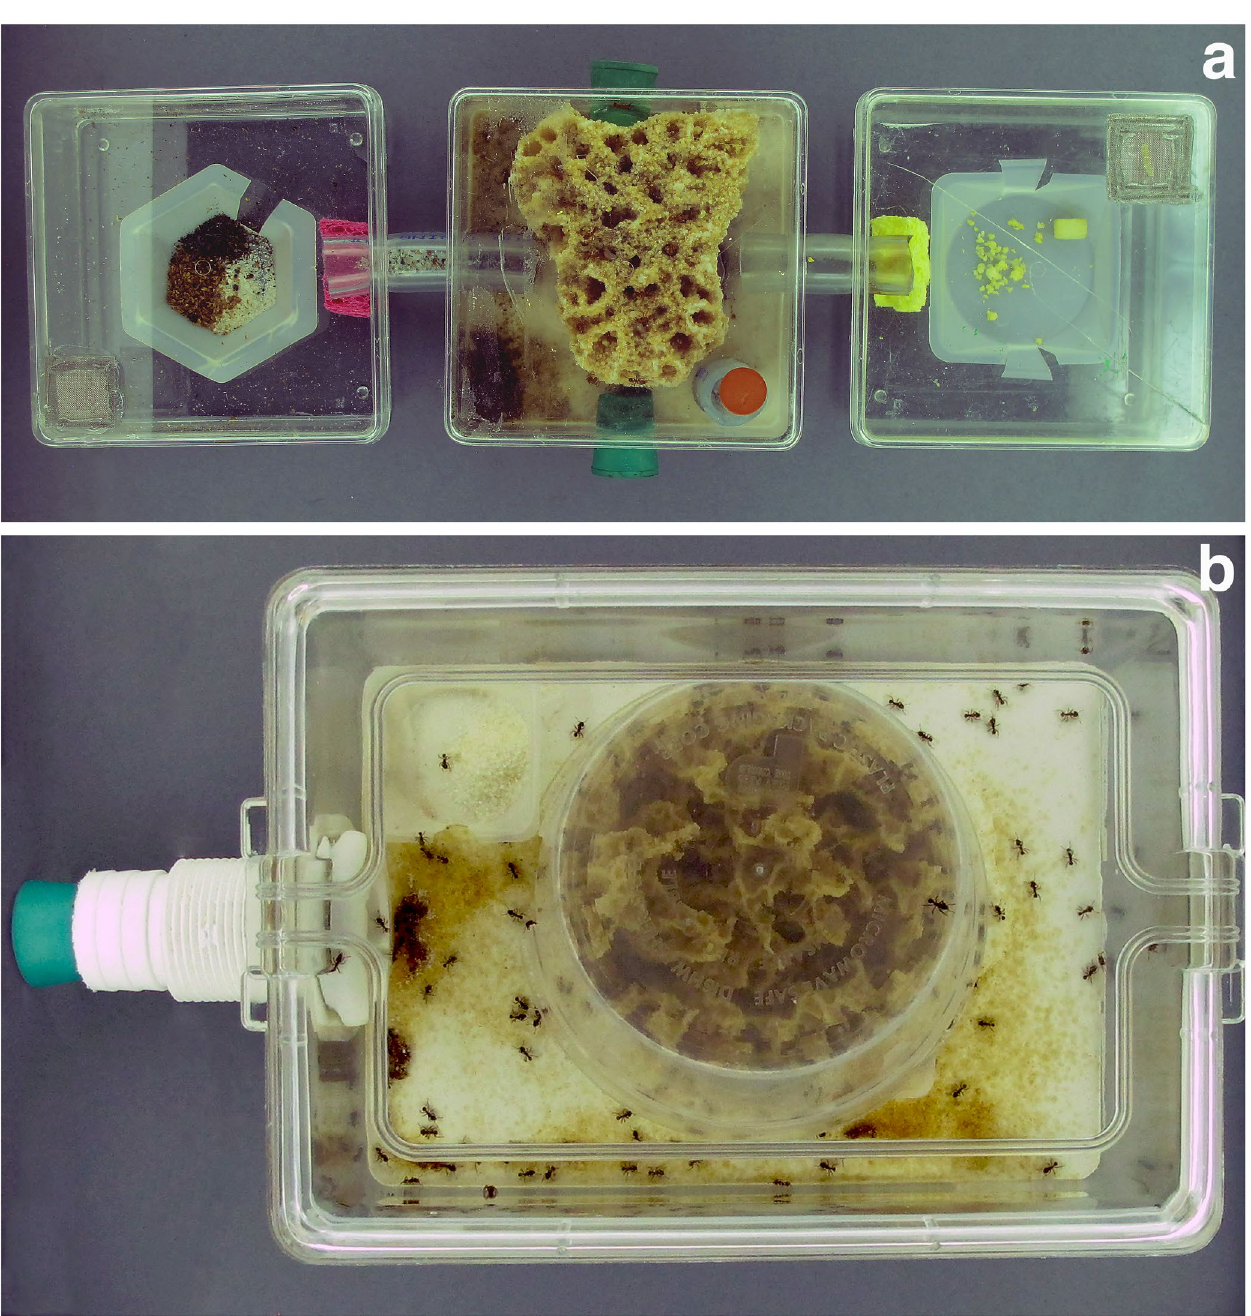
Fig 8. Examples of live colonies maintained in the NMNH Ant Lab. a. Nest of Trachymyrmex cf. bugnioni (TRS141003–04). b. Nest of Sericomyrmex sp. (AJ141001–05) in large polystyrene nest box with a plaster bottom. To maintain constant high humidity, the fungus garden is temporarily covered by a plastic food storage